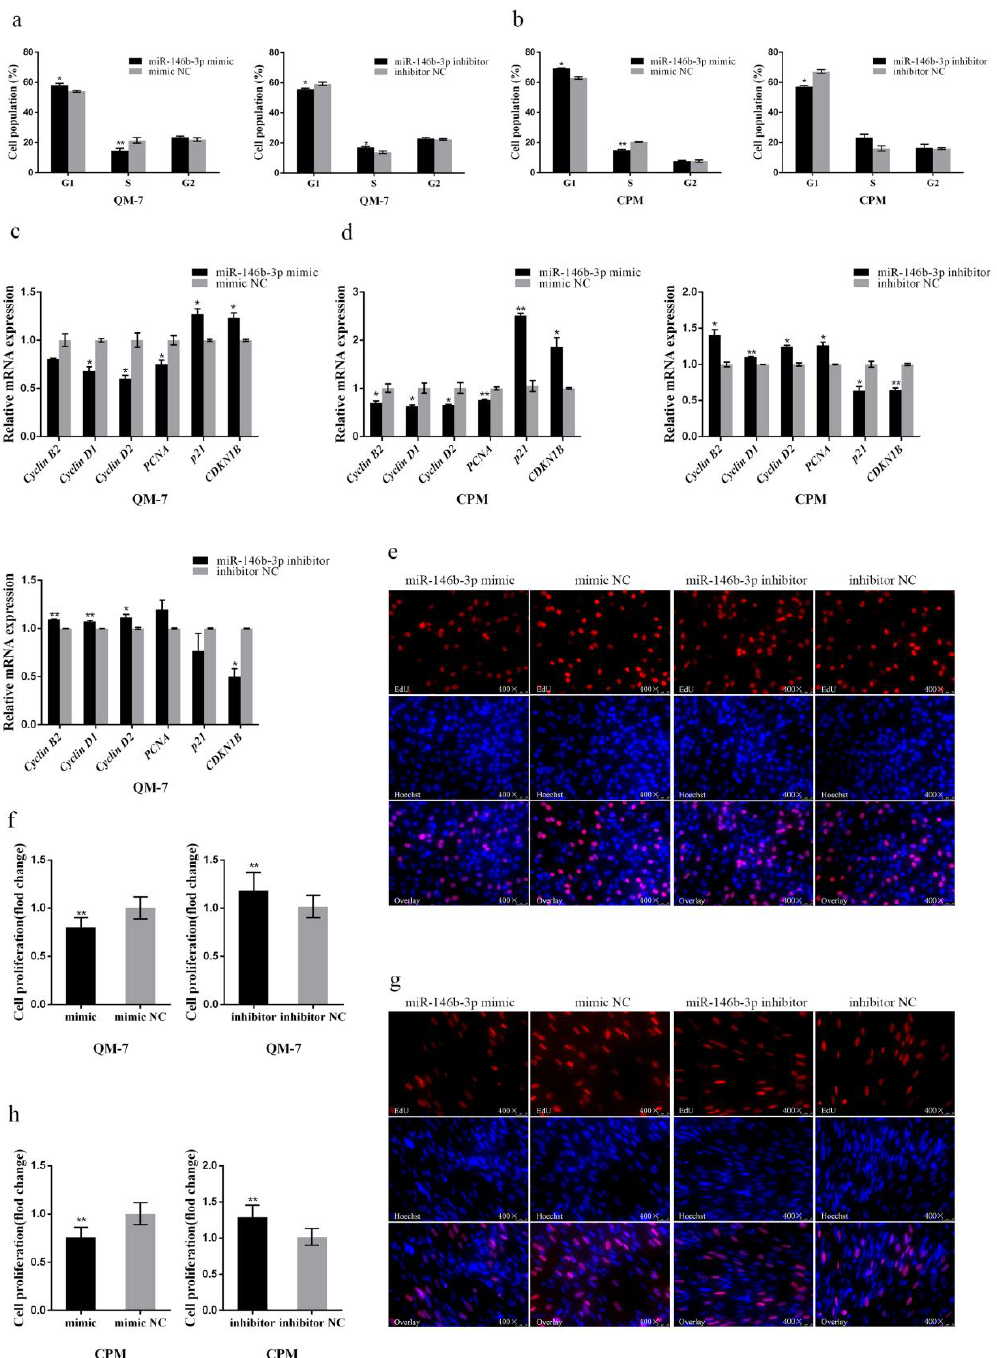
Figure 1. gga-miR-146b-3p inhibits myoblast proliferation. ( a , b ) Cell cycle analysis of QM-7 cells and chicken primary myoblasts (CPMs) after transfecting miR-146-3p mimic or inhibitor. ( c , d ) Relative mRNA expression of the cell cycle-related genes after transfection of miR-146-3p mimic or inhibitor in QM-7 cells and CPMs. ( e ) 5-Ethynyl-2 (cid:48) -deoxyuridine (EdU) staining of QM-7 cells after transfection of miR-146-3p mimic or inhibitor. ( f ) The fold change of proliferation rates of QM-7 cells with miR-146-3p mimic or inhibitor. ( g ) EdU staining of CPMs after transfection of miR-146-3p mimic or inhibitor. ( h ) The fold change of proliferation rates of CPMs with miR-146-3p mimic or inhibitor. Results of all groups are shown as mean ± standard error of the mean (S.E.M.) of three independent assessment methods. Statistical significance of the mean di ff erence was assessed using unpaired two-sample t -tests. * p < 0.05; ** p < 0.01. NC, negative